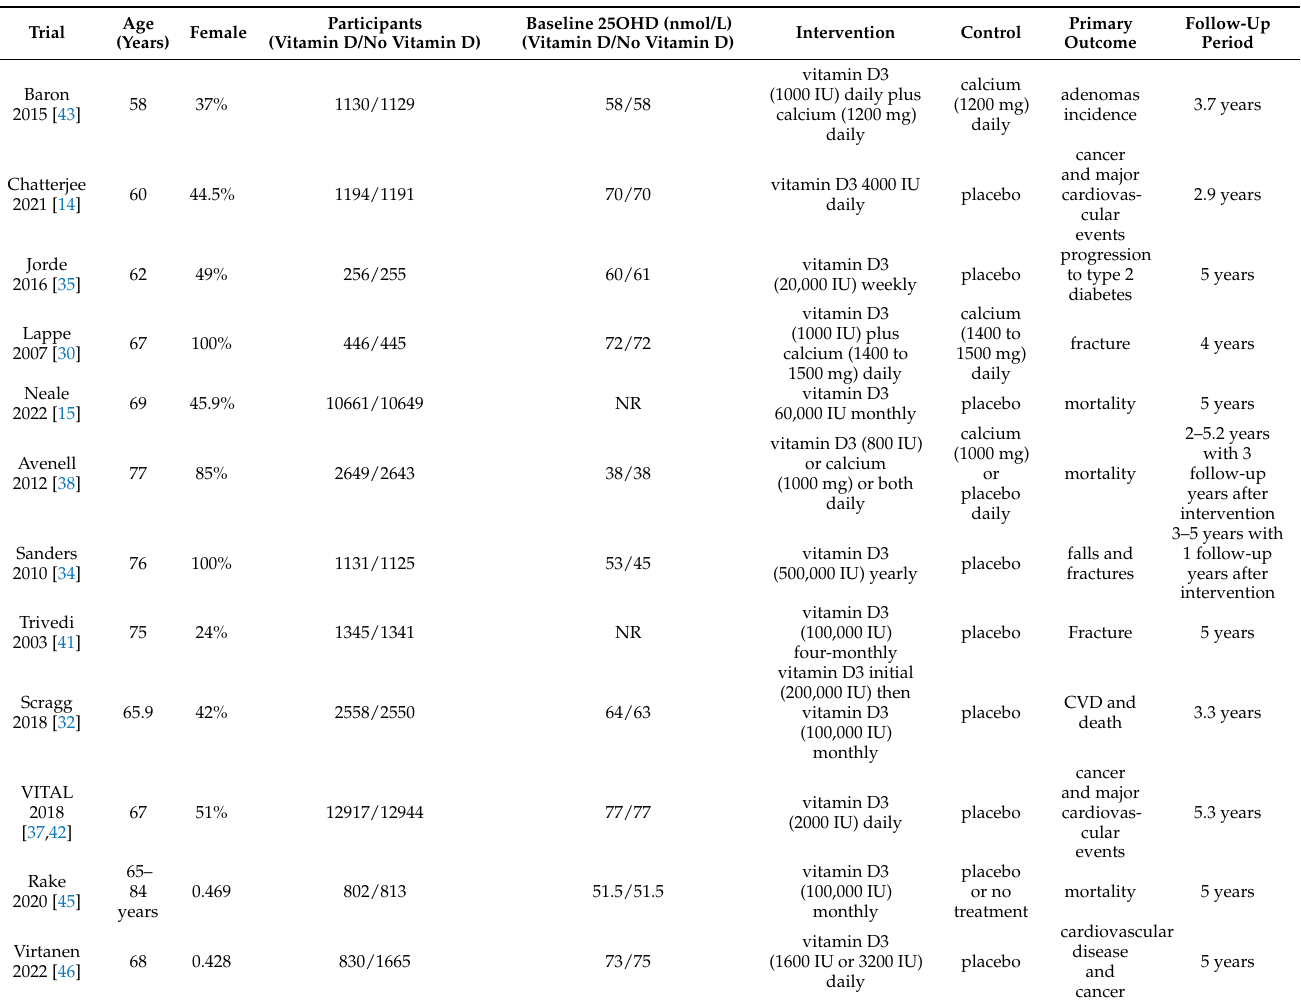
Table 1. Characteristics of the 10 Randomized Clinical